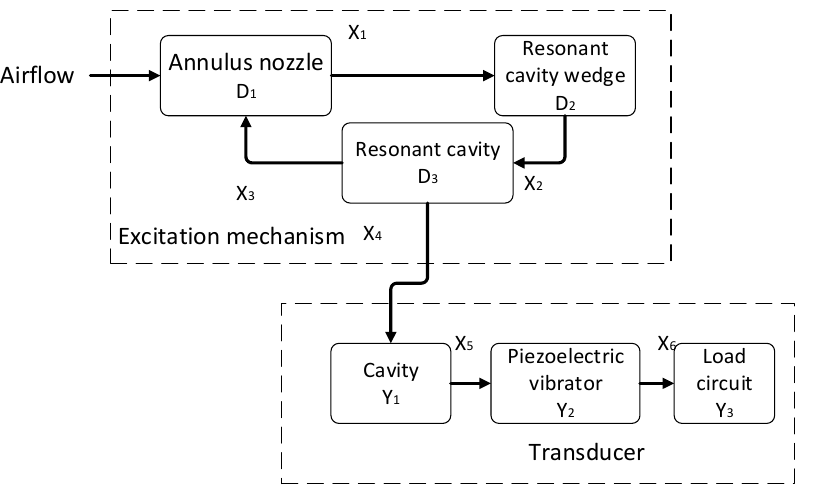
Figure 2. Working principle diagram of airflow induced acoustic generator.